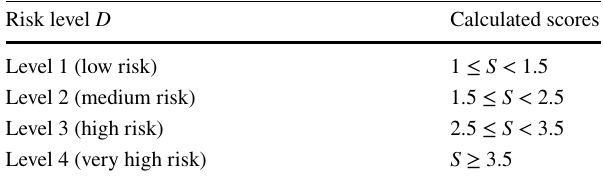
Table 2 Standard for collapse risk